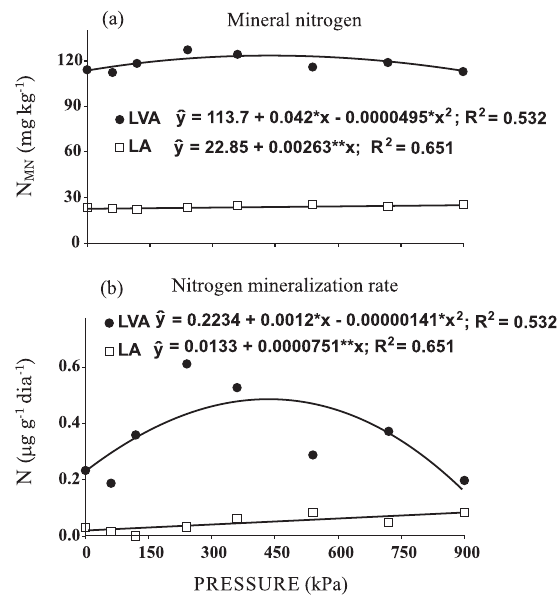
Figure 5. Mineral nitrogen (ammonium-N + nitrate- N) (a) and nitrogen mineralization rate (b) in two Oxisols subjected to increasing compaction pressures. (***, **, *: significance of the coefficients by the F-test, respectively, at the level of 0.1, 1 and 5 %).